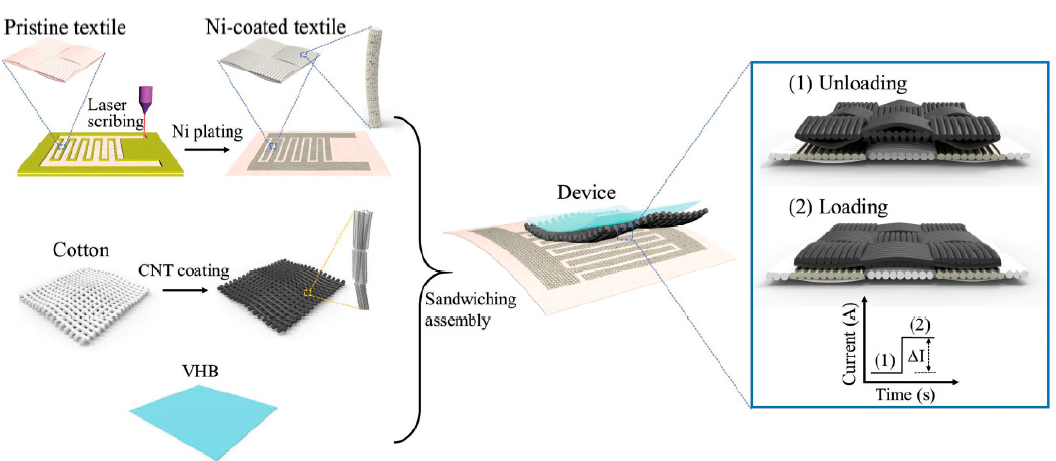
Figure 5. The fabrication of textile pressure sensor based upon nickel (Ni) and carbon nano tube coated textiles [101].